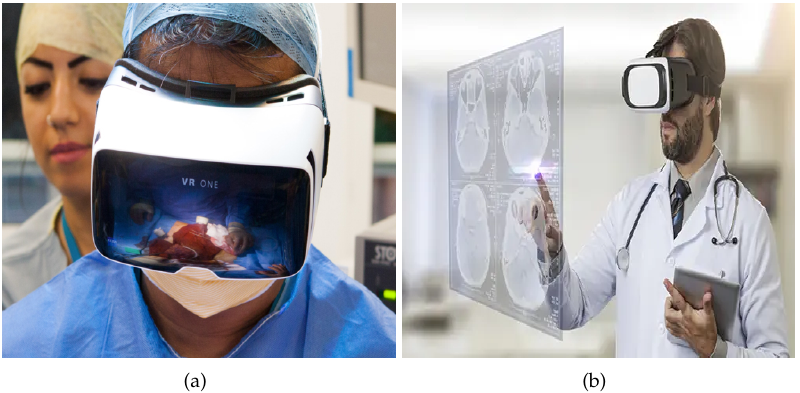
Figure 1. Usage of 3D-imaging in scientific and medical research. ( a ) Telesurgery and ( b ) volumetric